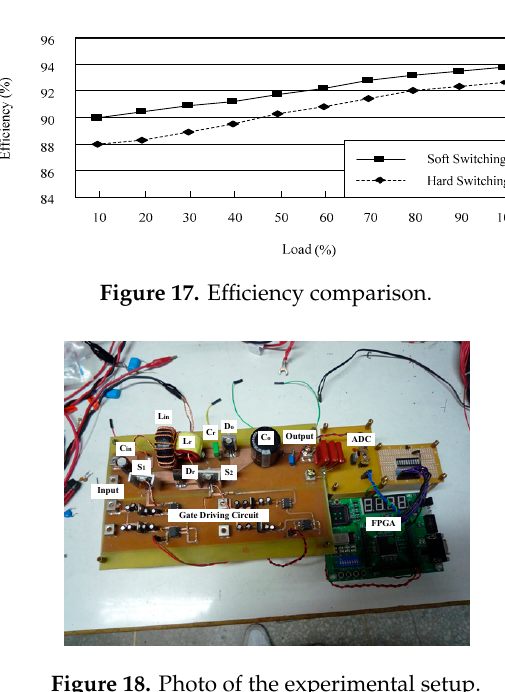
Figure 16. Efficiency measurement.